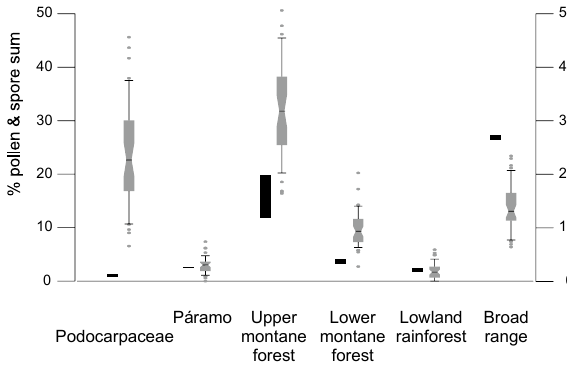
Figure 5. Comparison of the palynomorph percentages (based on total pollen and spores) of Podocarpaceae and the different vege- tation belts between two Holocene samples (black) and Pliocene samples between 4.7 and 4.2Ma (box–whisker plots).